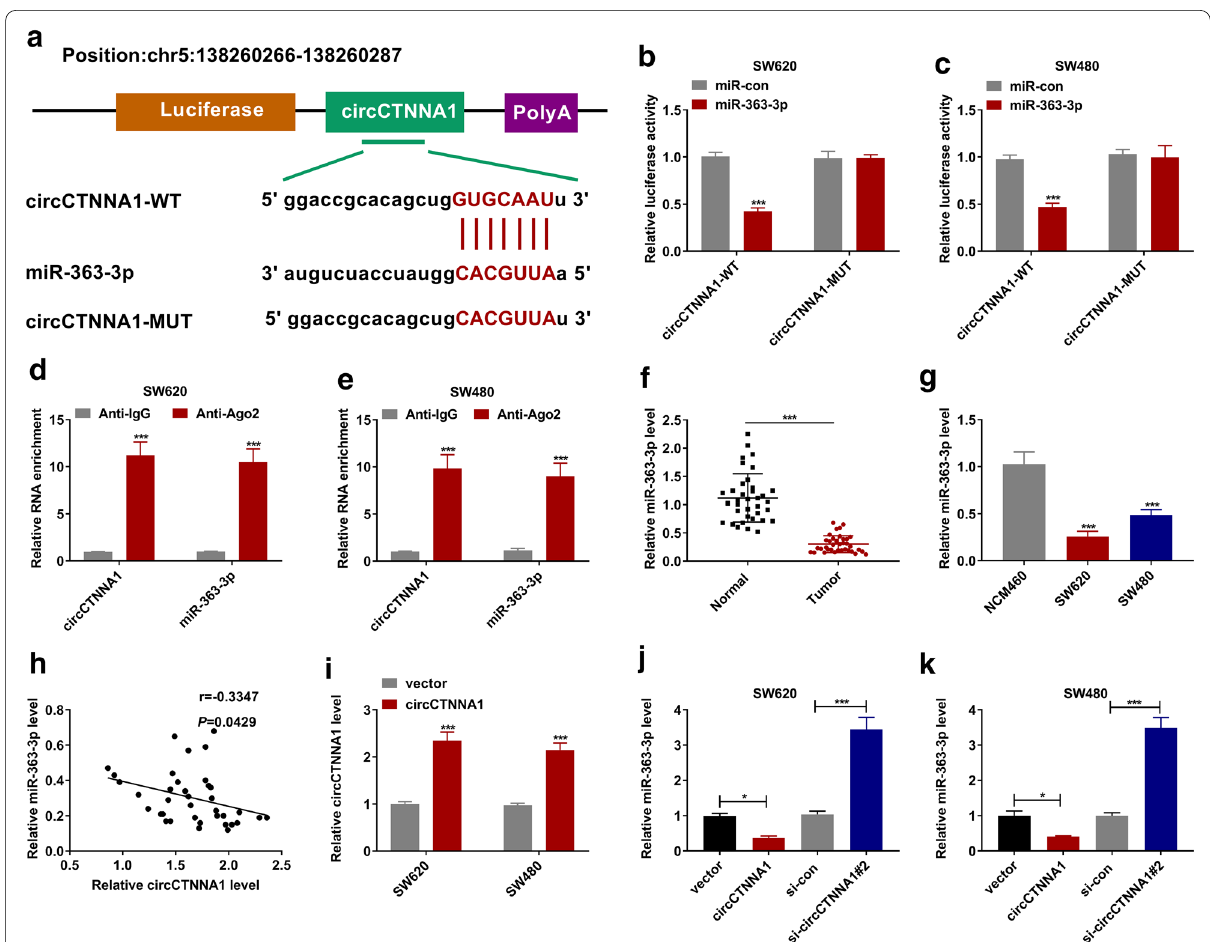
Fig. 3 CircCTNNA1 acted as a sponged for miR-363-3p. a The putative binding sites of miR-363-3p in circCTNNA1 were presented. Dual-luciferase reporter assay ( b , c ) and RNA immunoprecipitation assay ( d , e ) were used to verify the interaction between miR-363-3p and circCTNNA1. f The expression of miR-363-3p in CRC tumor tissues (Tumor) and adjacent normal tissues (Normal) was tested by qRT-PCR. g QRT-PCR was used to measure the miR-363-3p expression in NCM460 cells and both CRC cell lines (SW620 and SW480). h The correlation between miR-363-3p and circCTNNA1 was evaluated using Pearson coefficient correlation. i The transfection efficiency of circCTNNA1 overexpressing vector was confirmed by testing circCTNNA1 expression in SW620 and SW480 cells. j , k SW620 and SW480 cells were transfected with vector, circCTNNA1, si-con or si-circCTNNA1#2. The expression of miR-363-3p was measured by qRT-PCR. * p < 0.05, *** p <